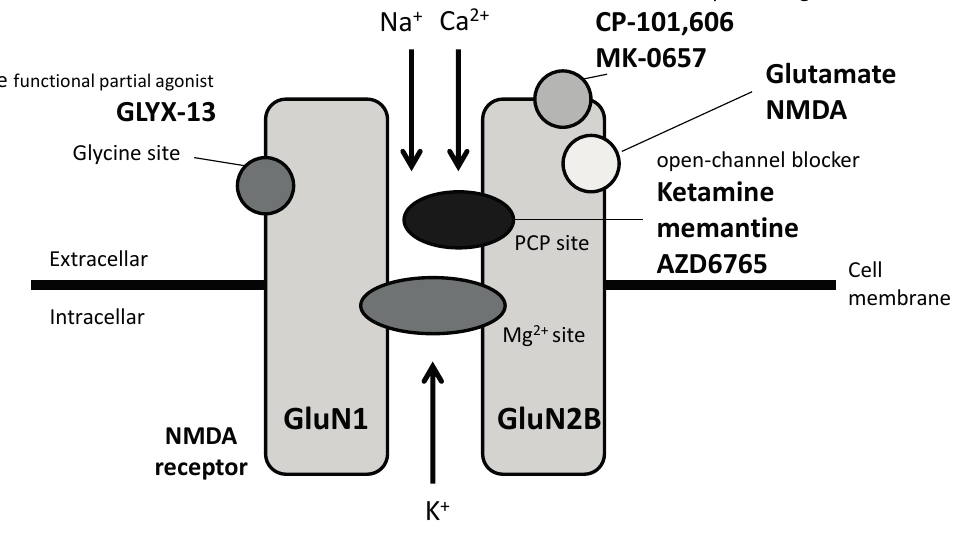
Figure 1. Antidepressant candidates acting on NMDA